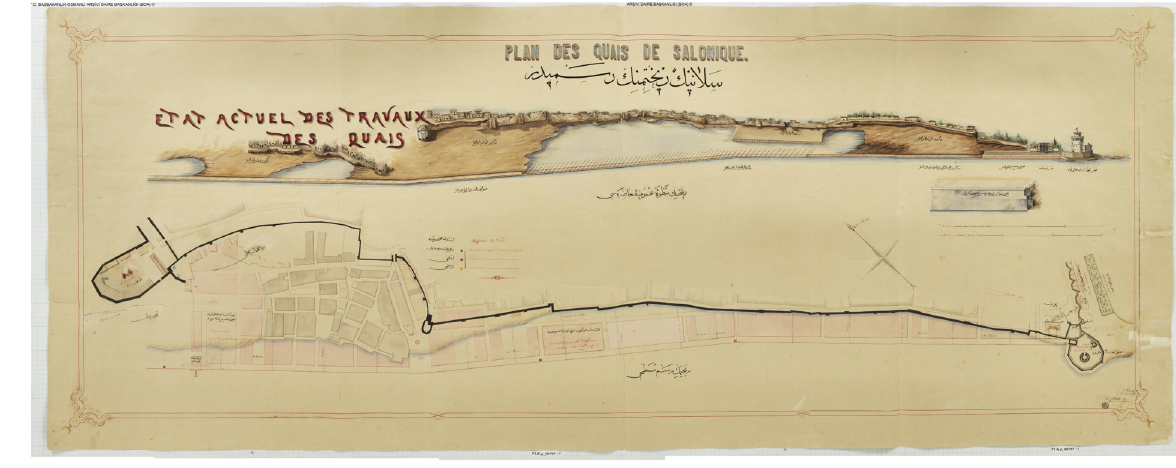
FIG. 8 The dock plan and illustration of Salonica, dating 1872. The plan ends on the right with Tour Blanche and does not include the areas in the East of the city that were developed and populated at the end of the nineteenth century, ©Devlet Arşivleri Başkanlığı [Ottoman